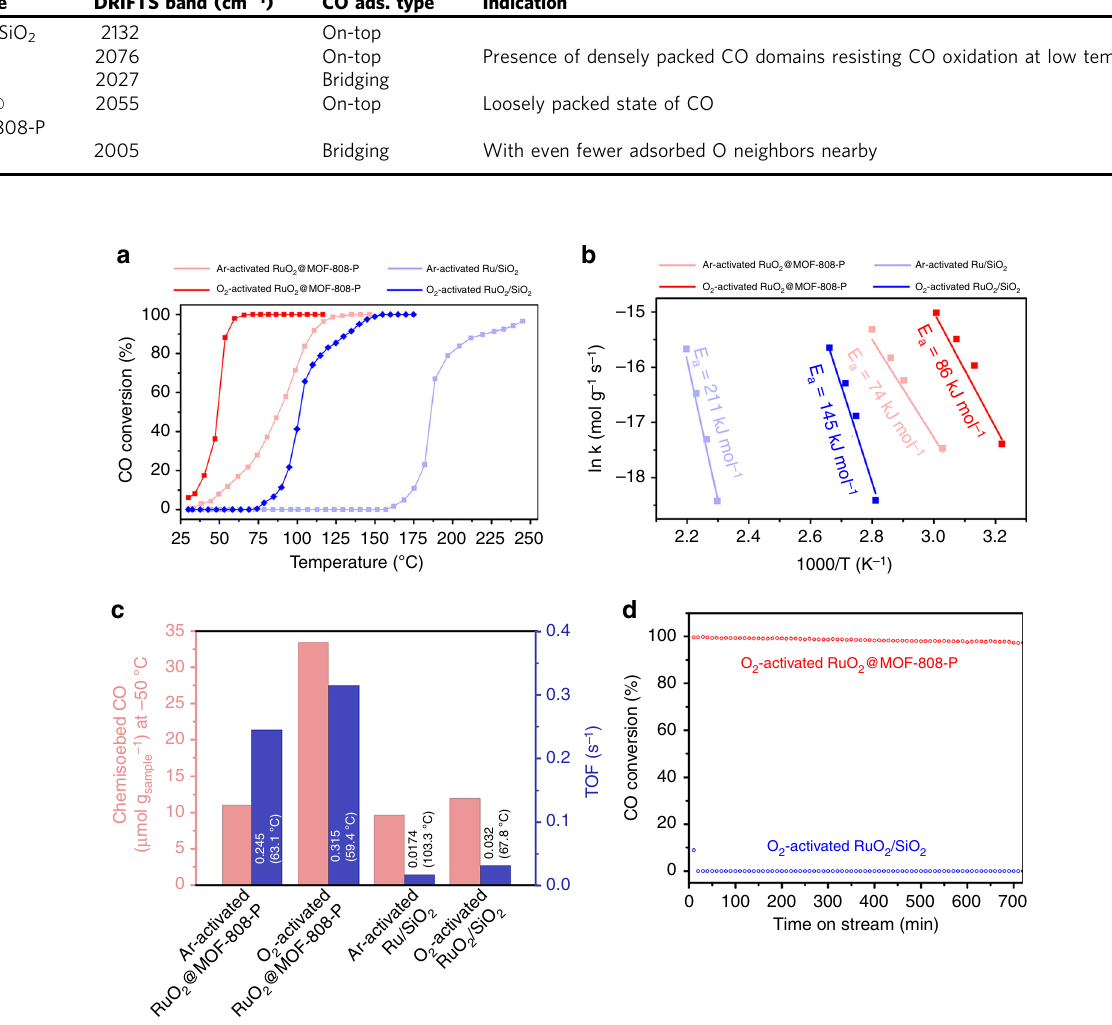
Fig. 4 CO oxidation performance over RuO 2 /SiO 2 and RuO 2 @MOF-808-P catalysts. a CO conversion pro fi les at weight hourly space velocity (WHSV) of 2000L g Ru − 1 h − 1 with 15 mg catalysts. b Arrhenius plots and calculated apparent activation energies ( E a ). c Chemisorbed CO at − 50 °C (to prevent CO 2 formation during the measurements) and calculated turnover frequency (TOF, conversion per unit site per unit time). d Stability test using O 2 -activated RuO 2 /SiO 2 and RuO 2 @MOF-808-P catalysts (2000 L g Ru − 1 h − 1 , 15 mg catalysts) at 100 °C. Experimental details are given in Supplementary Section 4.2. Source data are provided as a Source Data fi